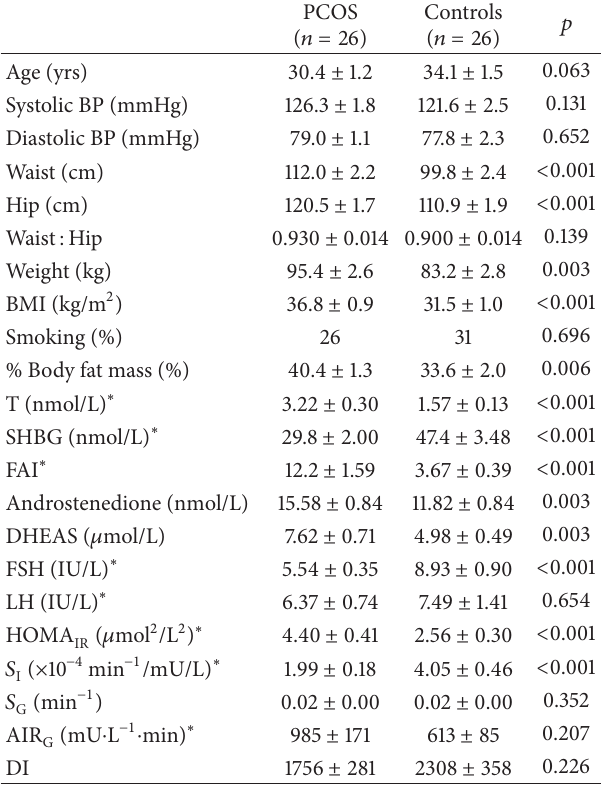
Table 1: Baseline characteristics of all subjects ( 𝑛 = 52